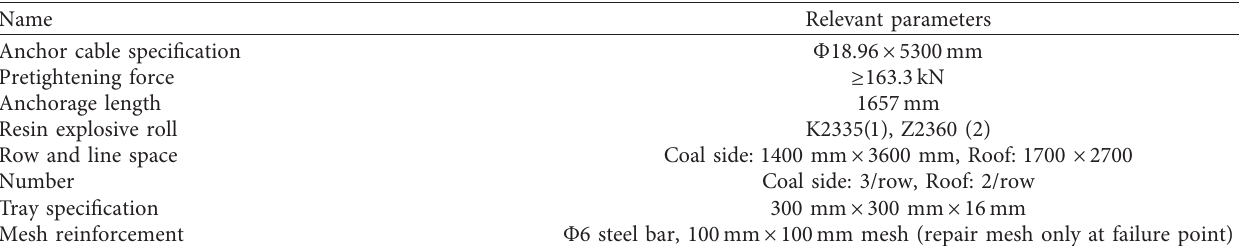
Table 6: The parameters of the cable reinforcement.